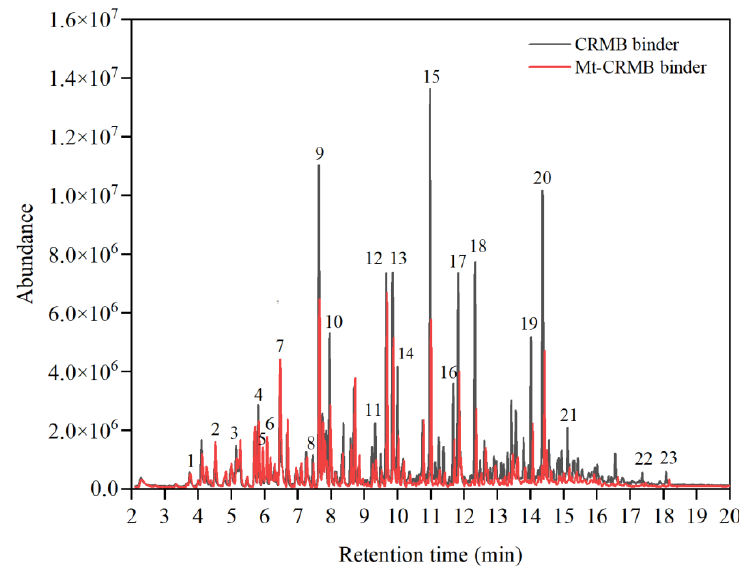
Figure 7. VOCs GC-MS chromatograms of CRMB and Mt-CRMB binders.